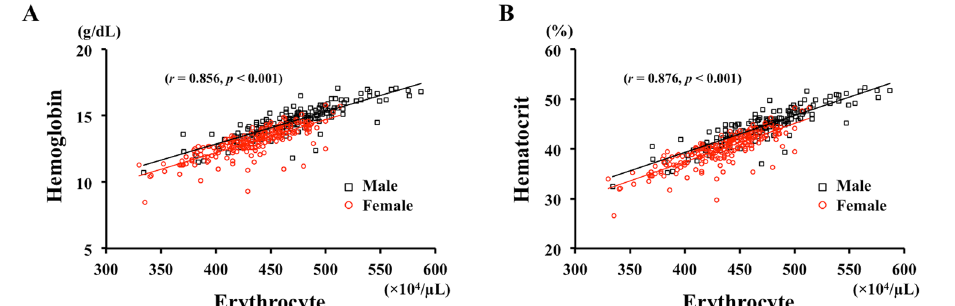
Figure 3. Correlation between the erythrocyte concentration and the hemoglobin concentration and the hematocrit percentage. The erythrocyte concentration was significantly and positively correlated with the hemoglobin concentration ( r = 0.856, P < 0.001) ( A ) and hematocrit percentage ( r = 876, P < 0.001) ( B